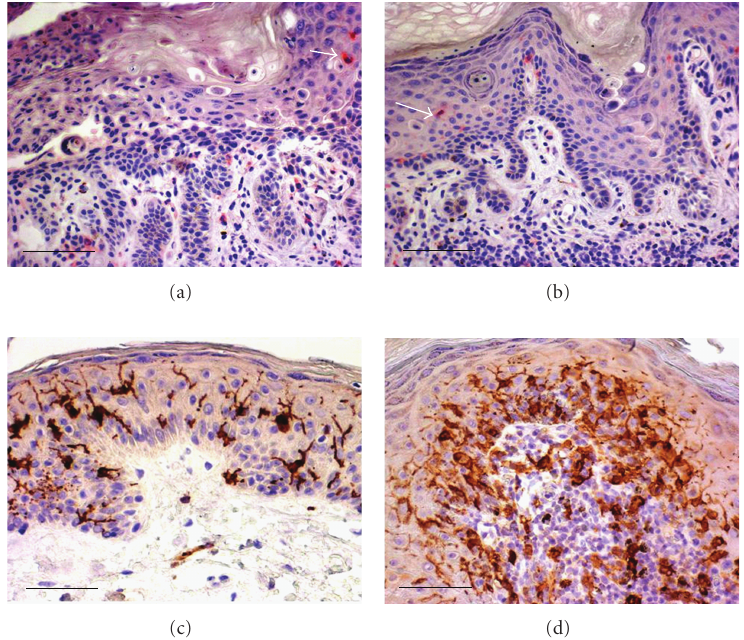
Figure 3: Few CD1a+ LCs (an intraepidermal CD1a+ LC is indicated by the arrow), small in size, and without evident dendrites, in two cases of Darier’s disease ((a), (b)). Normal skin showing more numerous, larger CD1a+ LCs, with long dendrites (c). An increased number of both epidermal and dermal CD1a+ LCs in a case of lichen ruber planus (d). Immunohistochemistry. Original magnification, × 200; Scale